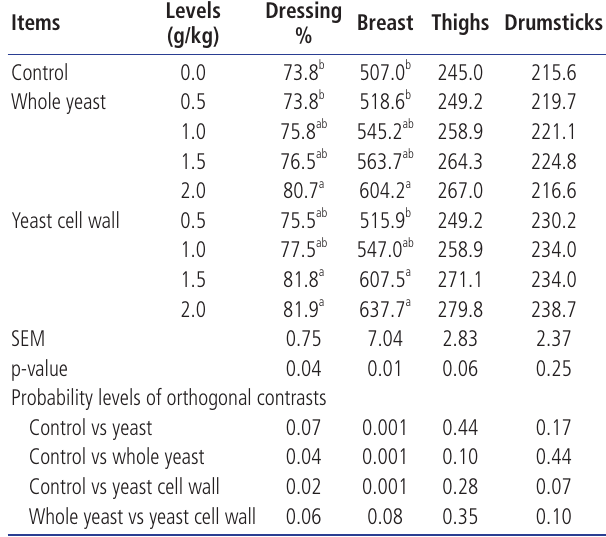
Table 7. Effect of dietary treatments on dressing percentage and absolute meat yield (g) of broiler chickens at 35 d of age Levels Dressing Items Breast Thighs Drumsticks (g/kg) %